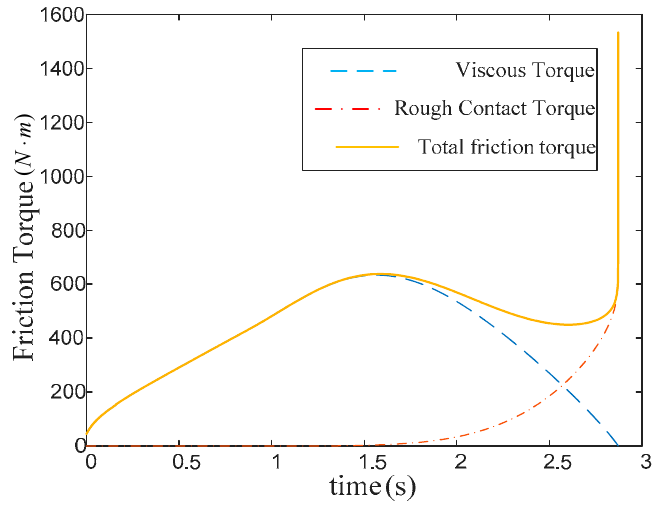
Figure 10. Friction torque curve.